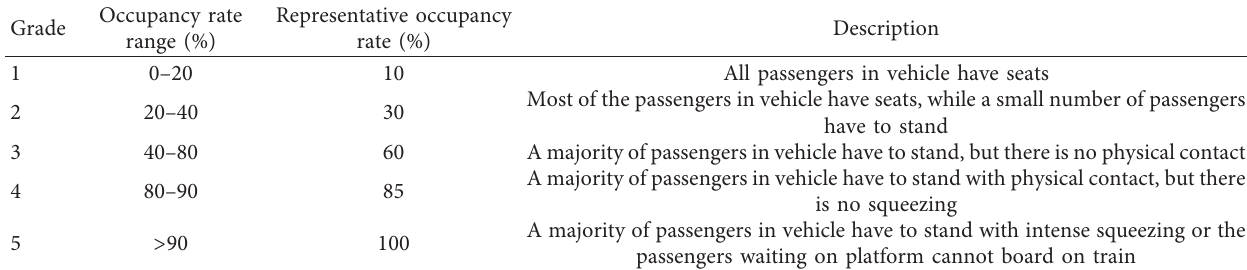
Table 2: The grading of